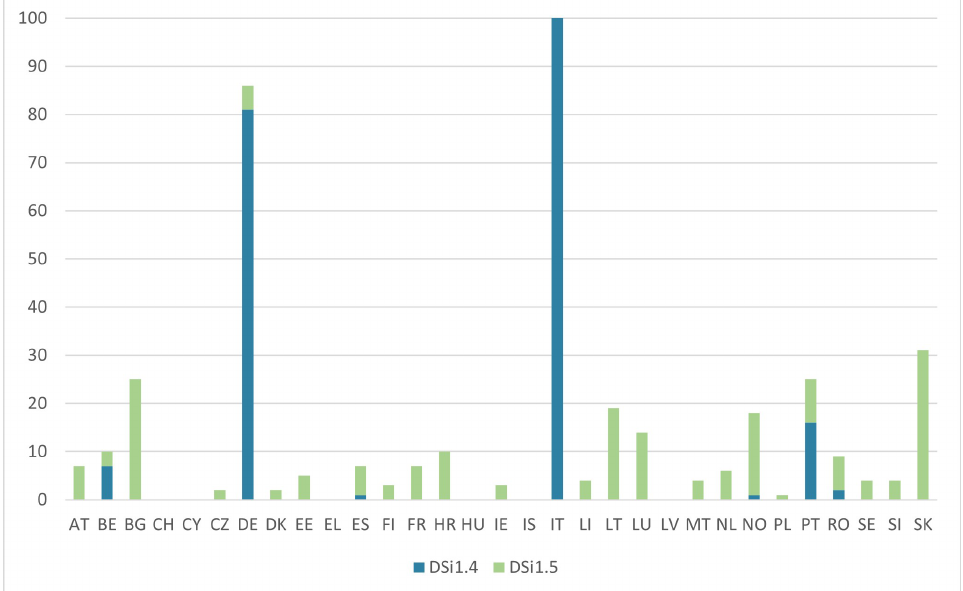
Figure 10. Indicators DSi1.4 and DSi1.5 for hydrography. As for the NSi2.1 and NSi2.2 indicators that represent the percentage of spatial datasets that are accessible through view and download services, respectively, Figure 11 shows the high percentage in most of the countries. We noticed curiosity at Germany and Italy, which are the two countries with all other indicators significantly higher than others, but in this case, when it comes to the percentage of really downloadable and viewable data